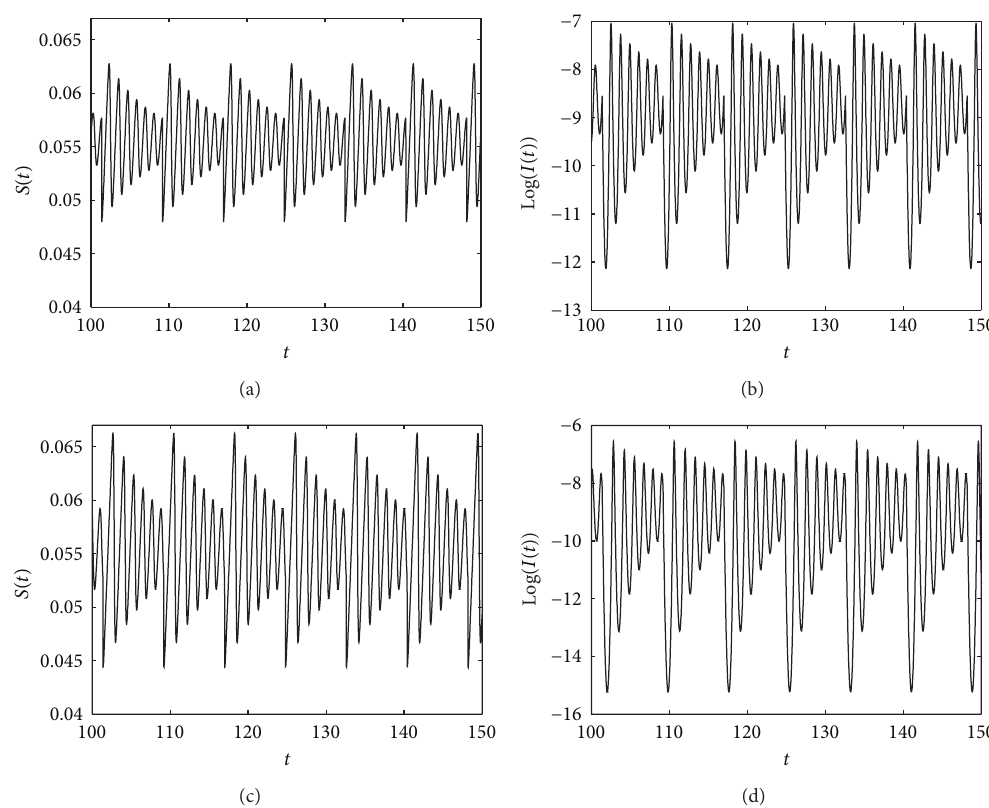
Figure 5: Coexistence of two stable attractors of model (4). Here 𝑝 max = 0.75 , 𝜃 = 0.2 , 𝑇 = 7.8 , and all other parameter values are given in Table 1. (a and b) The initial value (𝑆 0 ,𝐼 0 ) = (0.12, 0.05) ; (c and d) the initial value (𝑆 0 ,𝐼 0 ) = (0.1, 0.02)